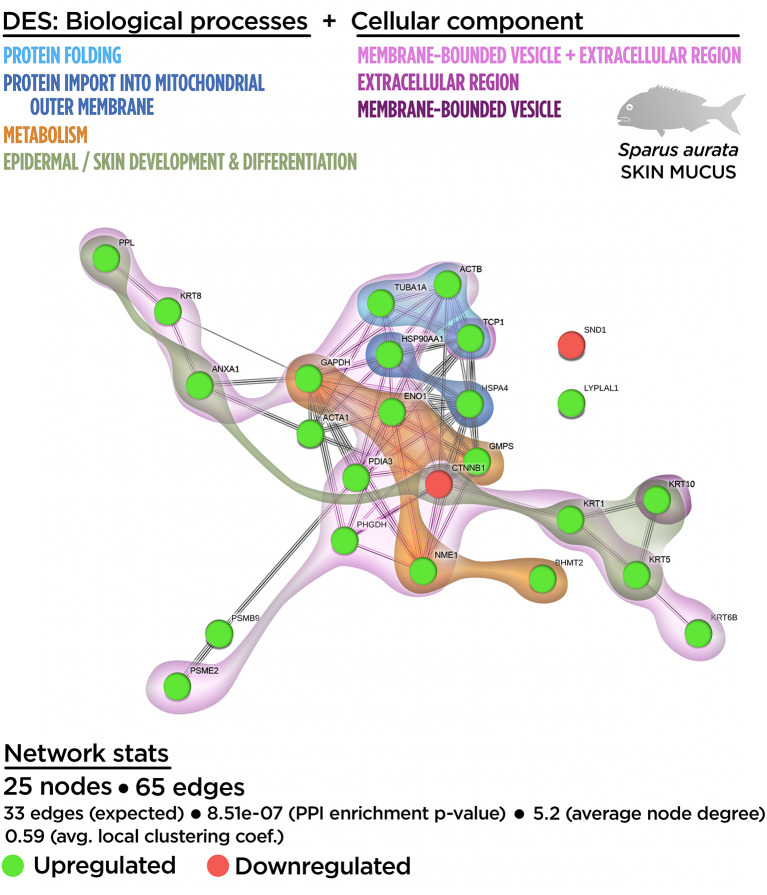
Integrative ameboid graphic for the biological processes and cellular components obtained from the skin proteinteractome analysis in gilthead sea bream fed with SDPP supplemented diet. Each node represents one differential expressed spots (DES) obtained from the skin proteomic analysis. The DES modulatory profile is represented with green (upregulated) and red (downregulated) into each node. The integrative cluster analysis groups the DESs classified into each of the biological processes or cellular components indicated in color (on top). Keratin, Type I Cytoskeletal 10 (KRT10) and T-complex 1 (TCP1) genes are exclusively clustered into membrane-bound vesicle and extracellular region, respectively. The functional network statistics (Network stats) details are indicated (bottom).